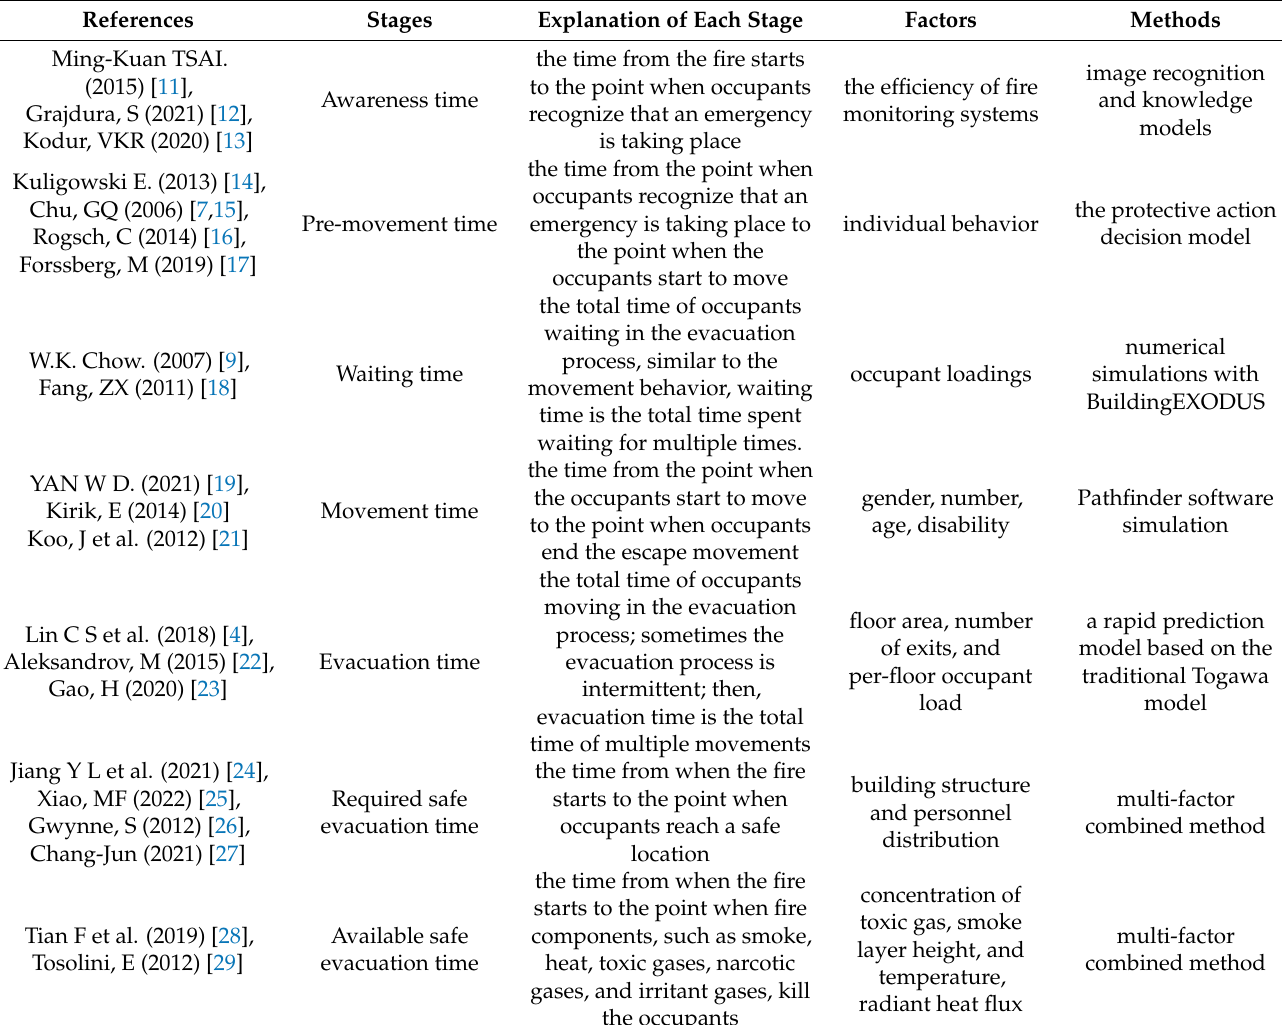
Table 1. The summary of evacuation time at different